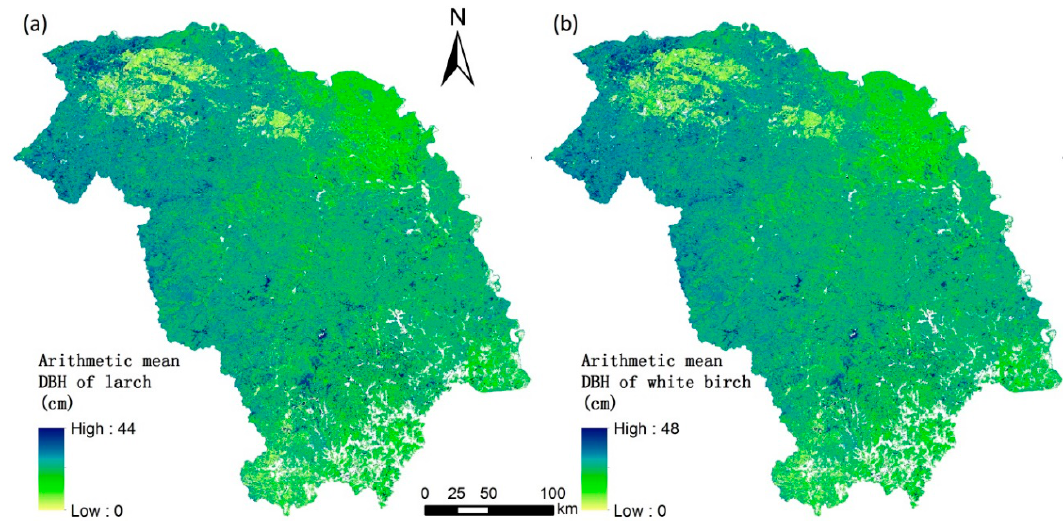
Figure 4. Maps of arithmetic mean DBH of larch ( a ) and white birch ( b ) based on Equations (4) and (5).